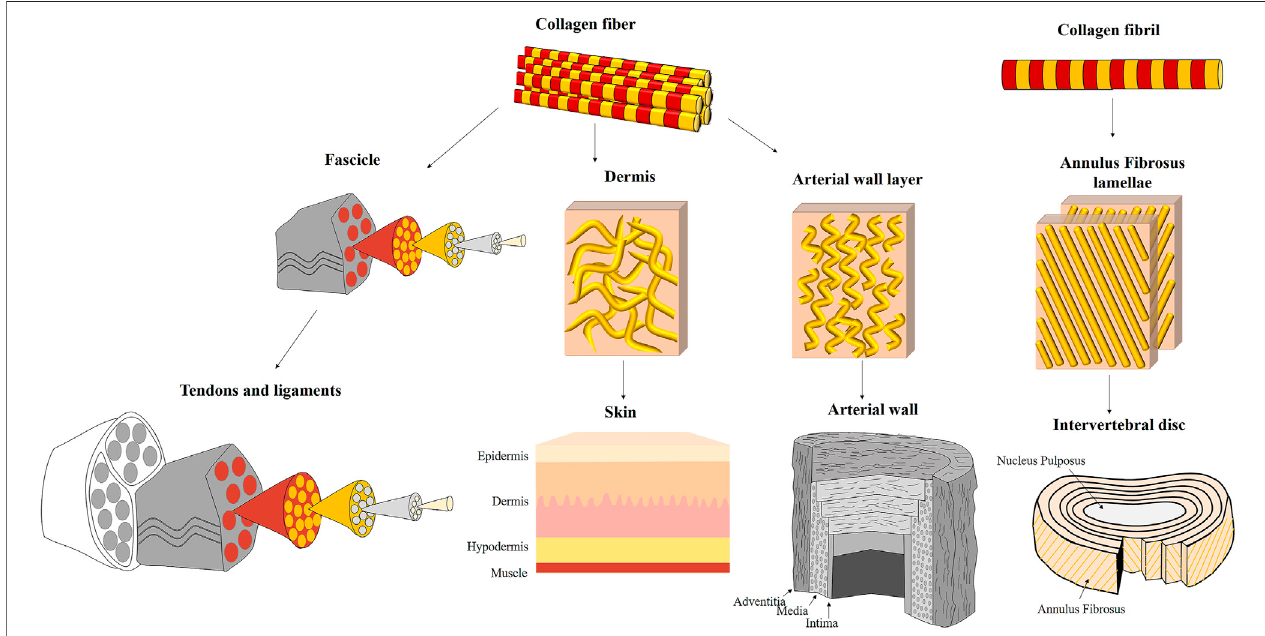
FIGURE 4 | Different supra fi brillar collagenous structures of fi brous tissues: tendons and ligaments, skin, arterial wall, and intervertebral disc. Tendons and ligaments are assembled from unidirectional fascicles that are highly aligned with the tension direction. The fascicles are assembled from parallel unidirectional collagen fi bers.Theskiniscomposedofthreelayers:epidermis,dermisandhypodermis(endodermis).Thecollagen fi bersinthedermis(whichistheload-bearinglayer)arewavy, dispersed and discontinuous. The arterial wall is composed of three layers: adventitia, media and intima. The collagen fi bers in the adventitia and media (which are the load-bearing layers) are oriented in wavy and discontinuous and oriented in speci fi c directions. However, they have a relatively large orientation distribution than tendonsand ligaments. Theintervertebraldisciscomposedofouterannulus fi brosus(AF)surrounding agelatinouscore(nucleuspulposus).TheAFisconstructed from 20 – 25 lamellae composed of parallel and crimped collagen fi brils oriented in an alternate arrangement of ± 30 ° with the vertebral axis.